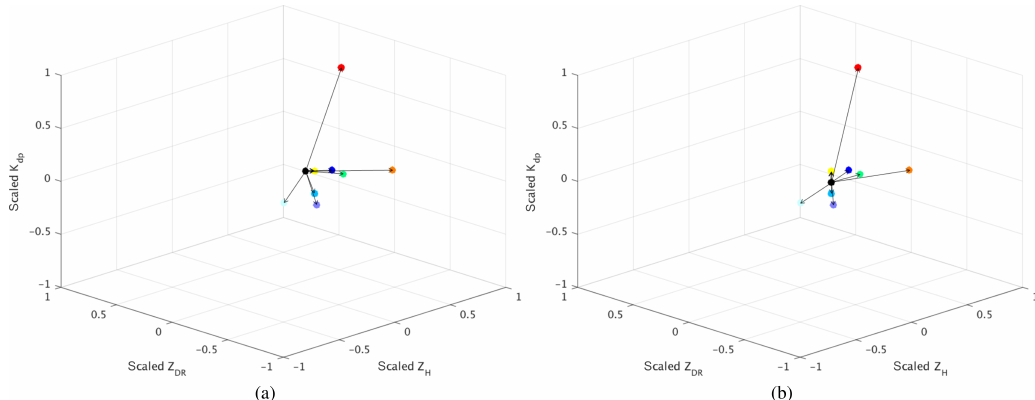
Figure 8. Example taken from the classification illustrated in Fig. 9: (a) lower entropy is 0.2753 and (b) higher entropy is 0.4756. Centroids are represented by points of different colour, according to the colour code from Fig. 9, with the observation being represented by a black point. The bold line corresponds to the smallest distance, the arrow indicating the actual